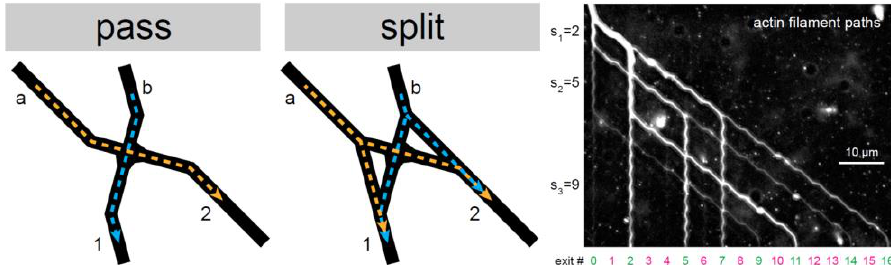
Figure 9. The schematic of behaviors of RCFs in a pass junction and a split junction and the results of parallel computation mediated by actin filaments. Reprinted with permission from Reference [39], Copyright 2016, National Academy of Sciences.